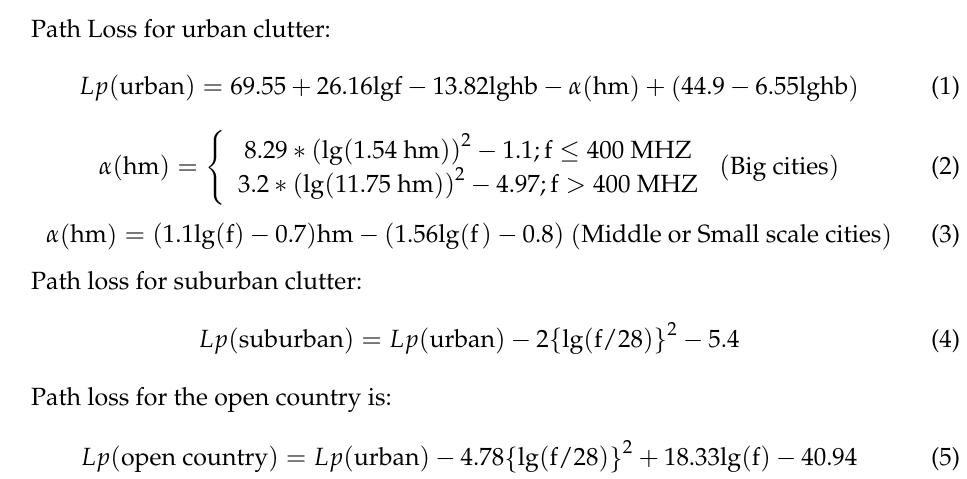
Figure 3. Attenuation Rate.